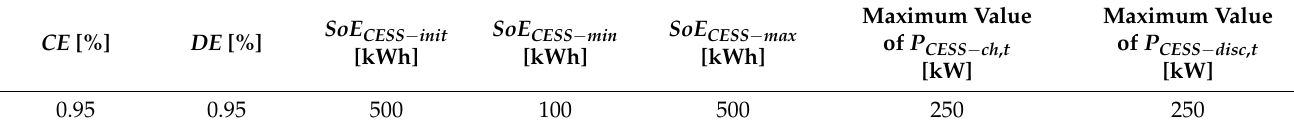
Table 3. Data of CESS.